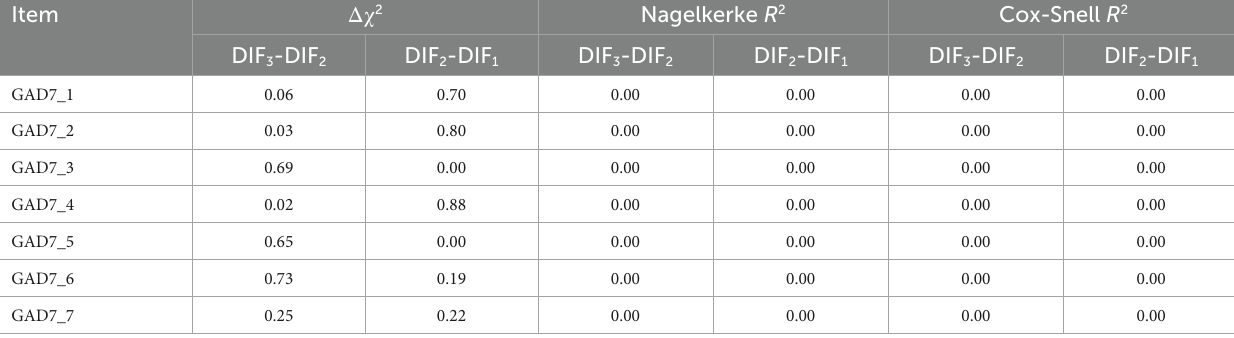
TABLE 7 Differential item functioning (DIF) for GAD-7 (group: sex of